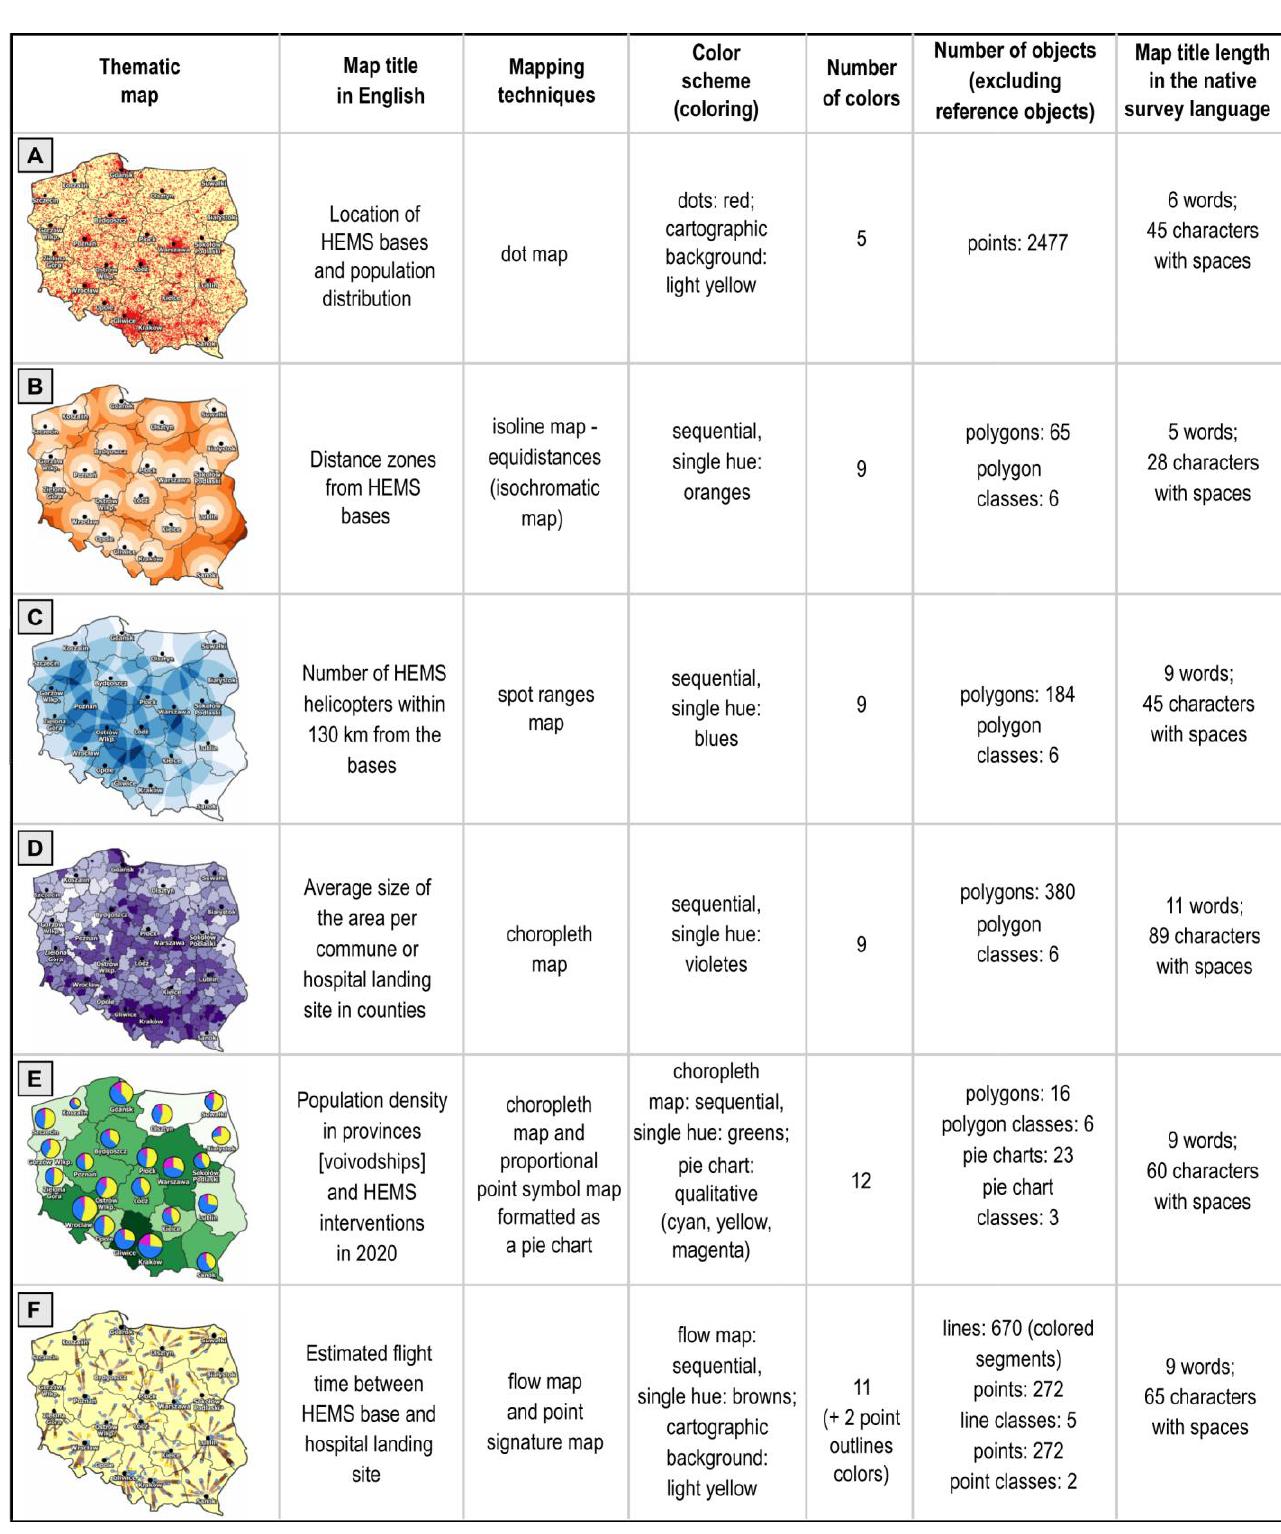
Figure 2. Comparison of the characteristics of the six thematic maps evaluated in the study (compare with Figure